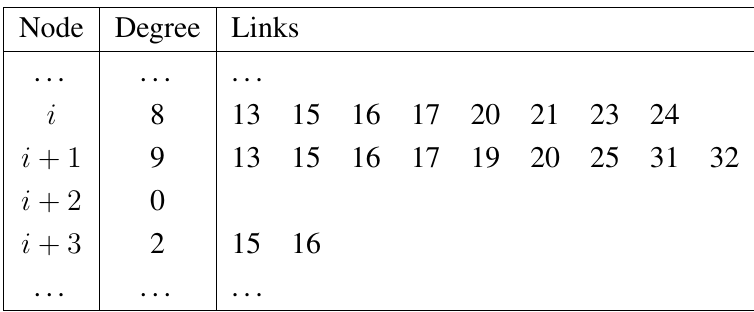
is the first node of a chunk. i